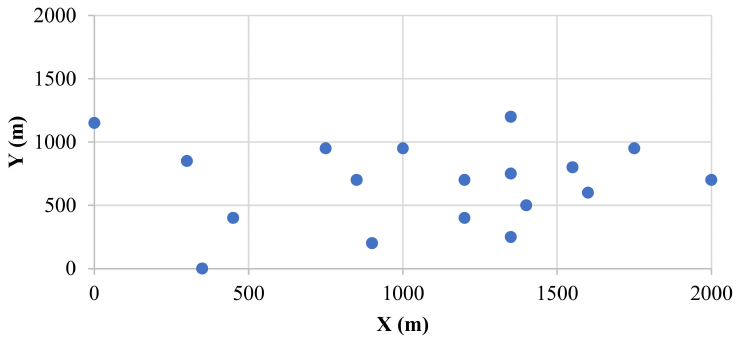
Figure 11. Position of turbines in Case